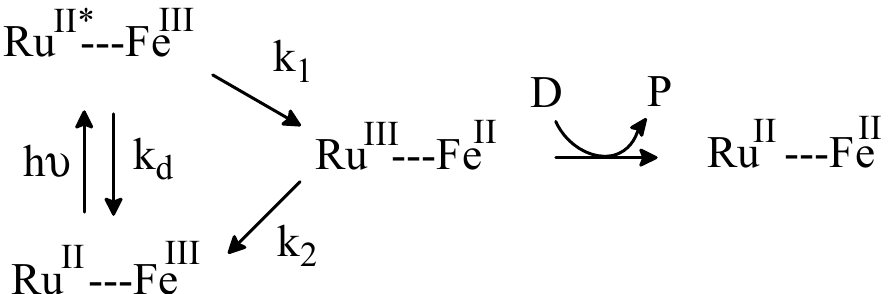
Scheme 1. Mechanism of photoreduction of heme Fe III in Ru-39-Cc.